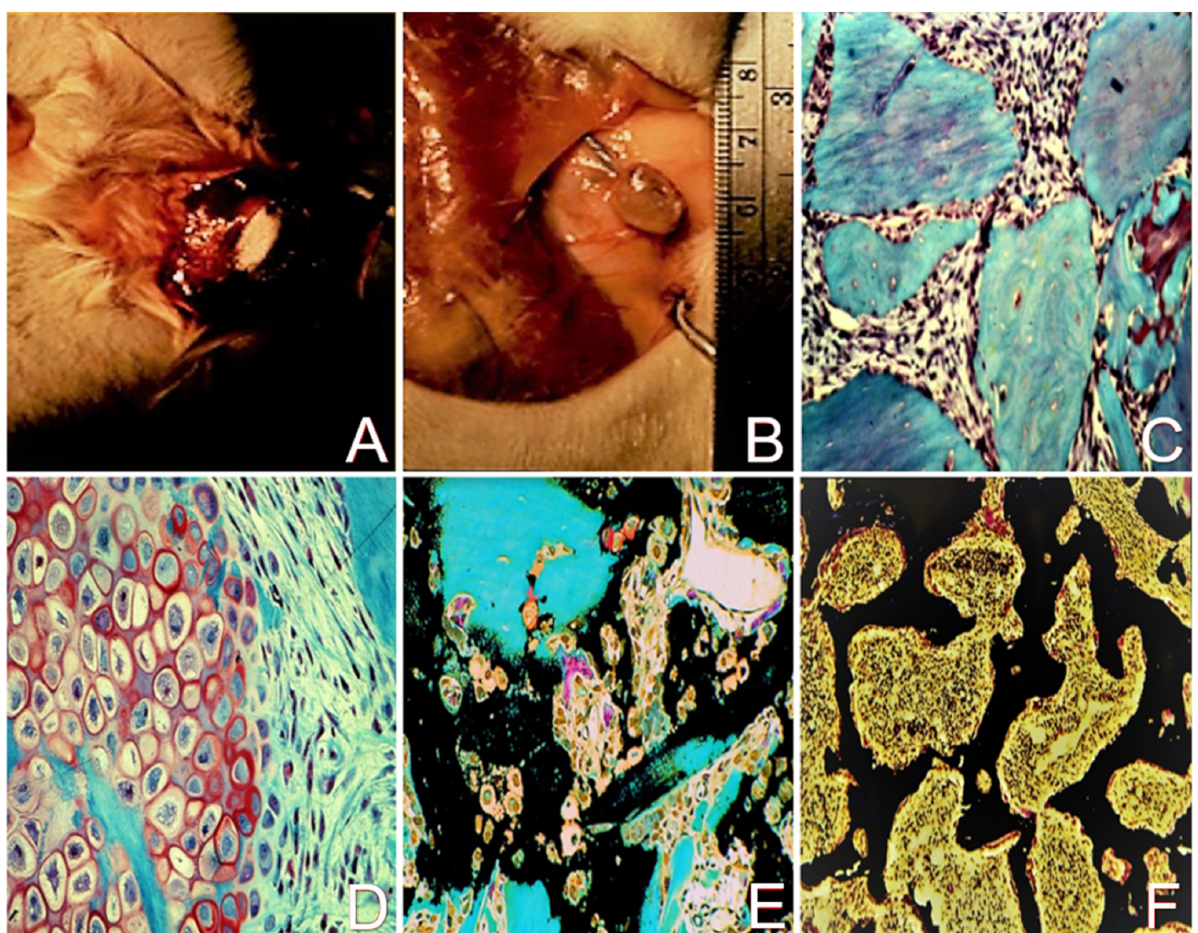
Figure 5. DBM model of endochondral ossification. ( A ) Implantation of DBM granules subcuta- neously along the thoracic musculature of CD rats. The implantation of DBM granules results in a temporally predictable sequence of mesenchymal stem/stromal cell infiltration, chondrogenesis, endochondral calcification, and ossification to a mature ossicle. ( B ) An ossicle after 21 days of development. The ossicle contains mature trabeculae and cortex. ( C ) Chemotaxis of infiltrating mes- enchymal stem/stromal cells on days 2–4 after DBM (blue) implantation. Homogeneous-appearing gray staining areas are demineralized bone granules (20 × ). ( D ) Chondrogenesis on days 6–10 after DBM implantation with the demonstration of mesenchymal stem/stromal cell differentiation and several maturing chondrocytes with Safranin O staining ECM (pink) (100 × ). ( E ) Cartilage calcification and early bone formation (black) on days 10–12 after DBM (blue) implantation (40 × ). ( F ) Mature trabecular bone (black) on days 14–21 within a surrounding cortex and hematopoietic marrow (20 × ). All histochemical stains are trichrome, hematoxylin and eosin, Safranin O, and silver nitrate [5]. Adapted from Ref. [8]. 2022. Roy K.